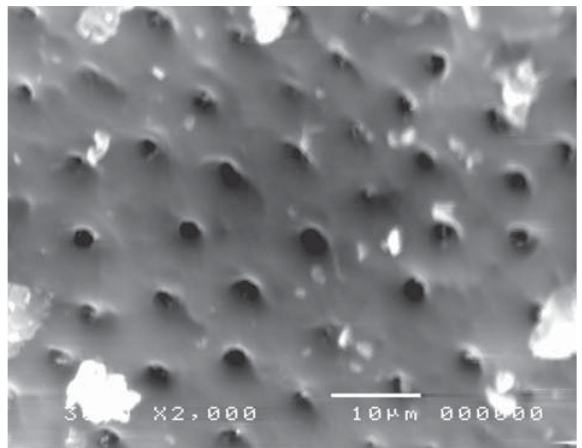
Figure 16- Electron-micrograph in gamma (GB) group subjected to conventional high speed turbine bur after acid etching, the dentinal tubules became more obvious, and the intertubular dentine appears more ablated than the peritubular one and the smear layer was removed